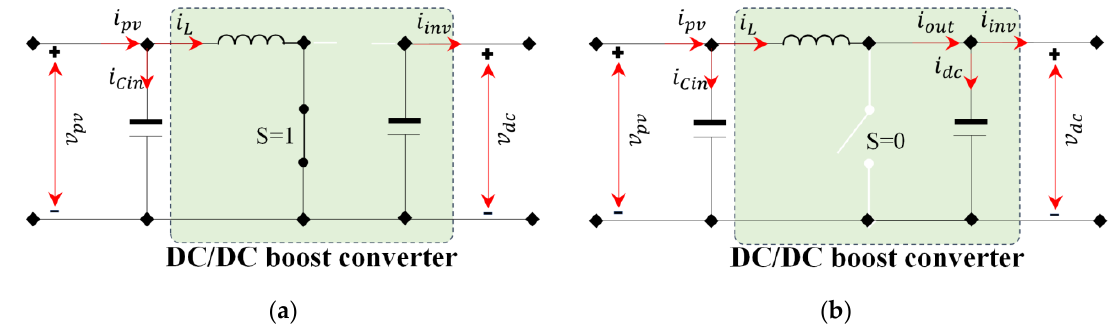
Figure 4. Equivalent boost circuit: ( a ) on state; ( b ) off state.